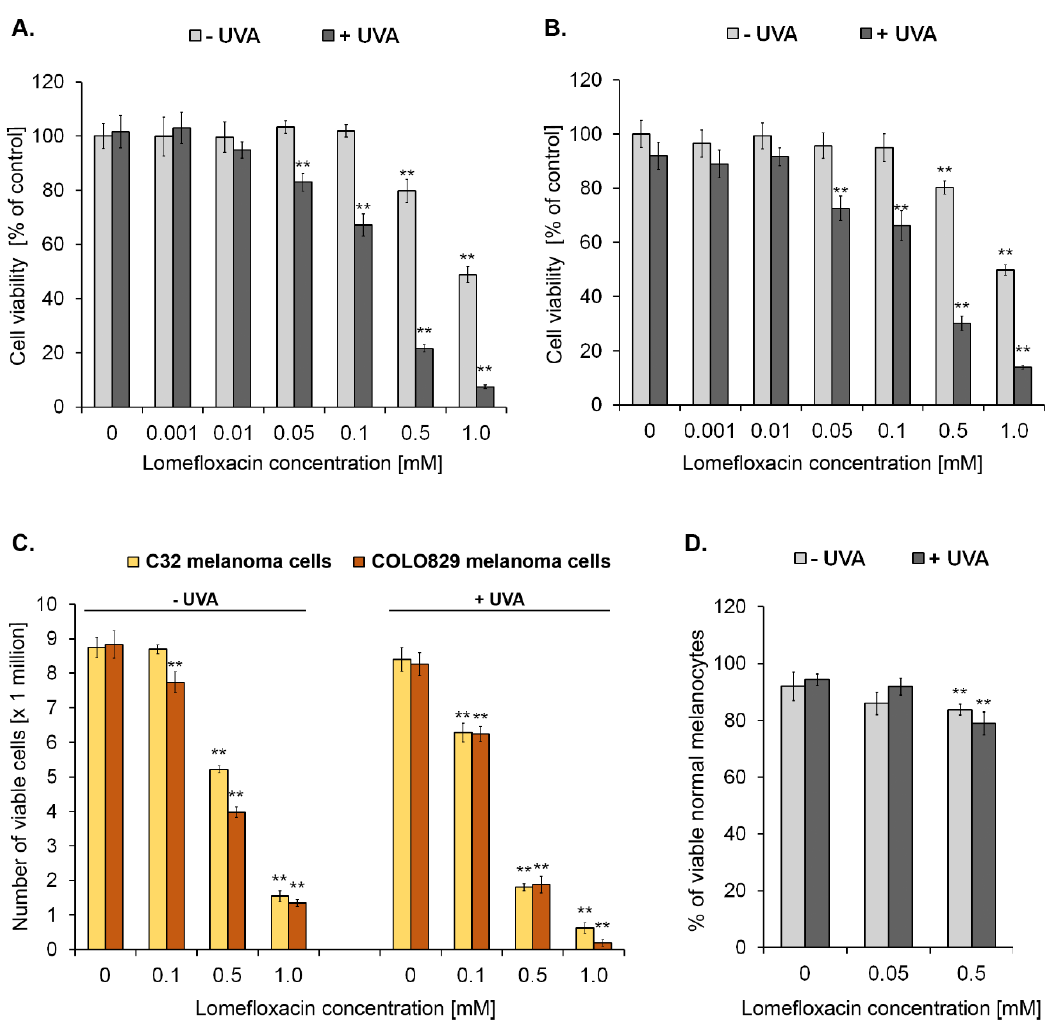
Figure 1. Simultaneous exposure of amelanotic C32 ( A ) and melanotic COLO829 ( B ) melanoma cells to lomefloxacin and UVA irradiation enhances the decrease in the viability of cells. The cells were pre-treated with lomefloxacin at the concentration range from 0.001 to 1.0 mM alone for 24 h or exposed to the drug and UVA irradiation (1.3 J / cm 2 ). Mean values ± SEM from three independent experiments ( n = 9) performed in triplicate are presented. ** p < 0.005 vs. control samples. Growth inhibitory effect of lomefloxacin and lomefloxacin co-treatment with UVA irradiation towards melanoma cells ( C ) and melanocytes ( D ). C32 and COLO829 cells were pre-treated with lomefloxacin at concentrations of 0.1, 0.5, and 1.0 mM alone for 24 h or exposed to the drug and UVA irradiation (1.3 J/cm 2 ). Melanocytes were pre-treated with lomefloxacin at concentrations of 0.05 and 0.5 mM alone for 24 h or exposed to the drug and UVA irradiation (1.3 J/cm 2 ). Mean values ± SEM from three independent experiments ( n = 9) performed in triplicate are presented. ** p < 0.005 vs. control samples.